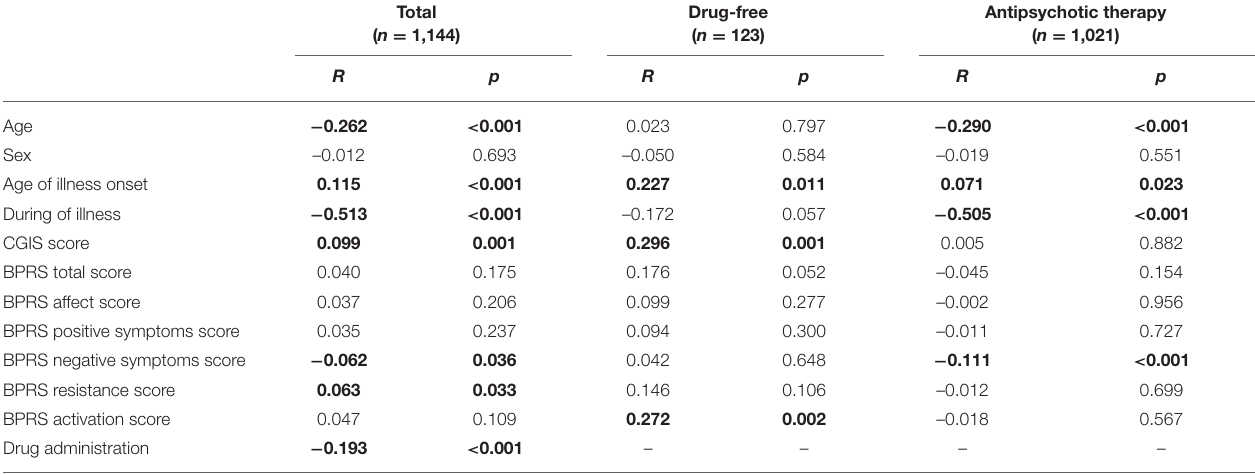
TABLE 2 | The spearman correlations analysis between NLR and CGIS and BPRS scores, and other